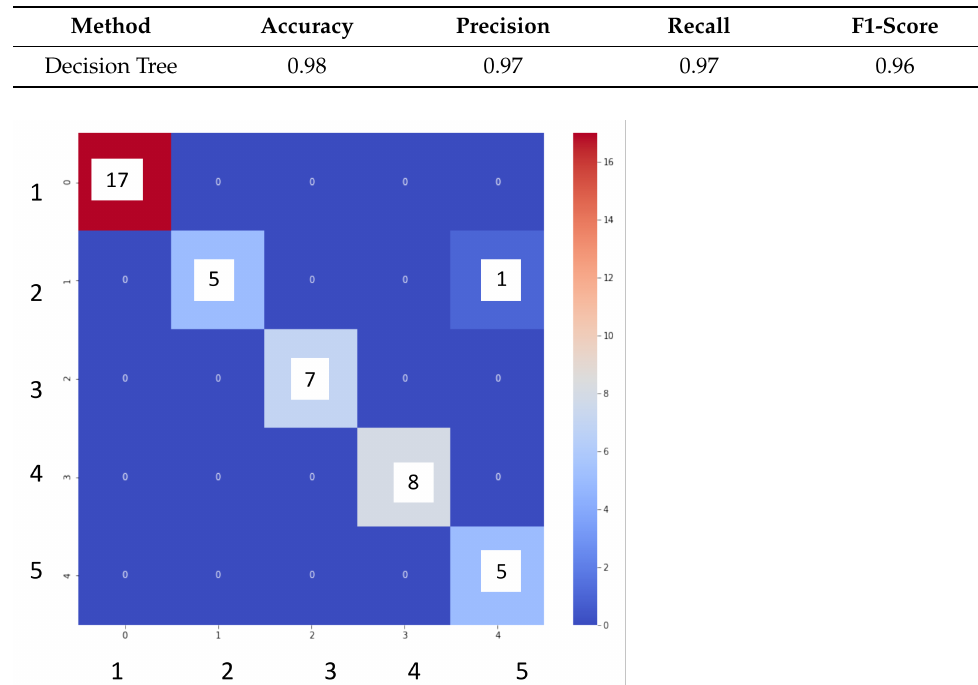
Table 8. Classification report for the decision tree method—flow and pressure data.